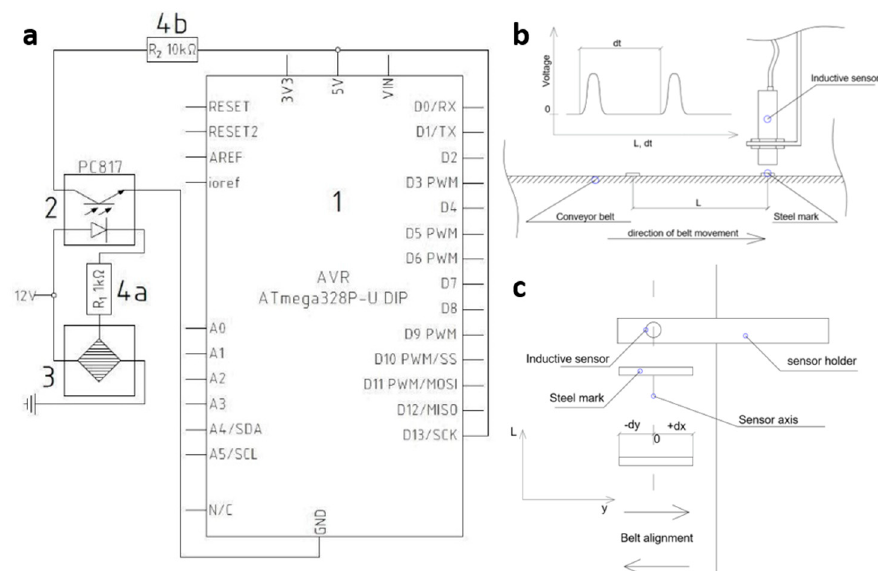
Figure 7. Measurement with the inductive sensor: ( a ) conveyor belt linear speed measurement system with inductive sensor (1—microcontroller, 2—linear opto-isolator, 3—inductive sensor, 4—resistors), ( b ) measurement with the inductive sensor—perspective view, ( c ) measurement with the inductive sensor—top view.